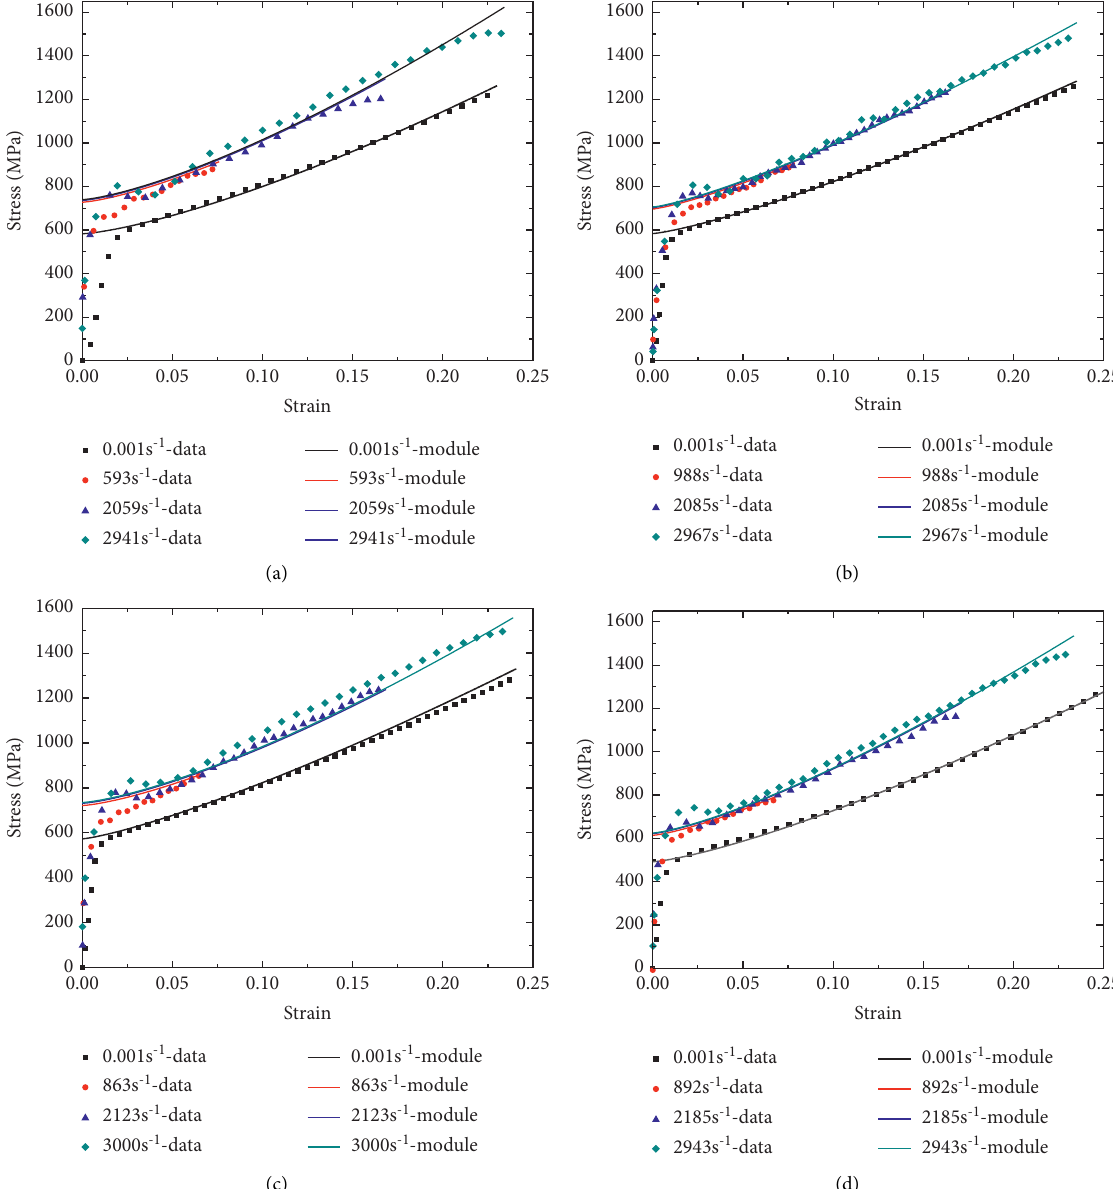
Figure 12: The fitting curve of stress-strain based on the original J-C model. (a) 350mm/s, (b) 650mm/s, (c) 950mm/s, (d)